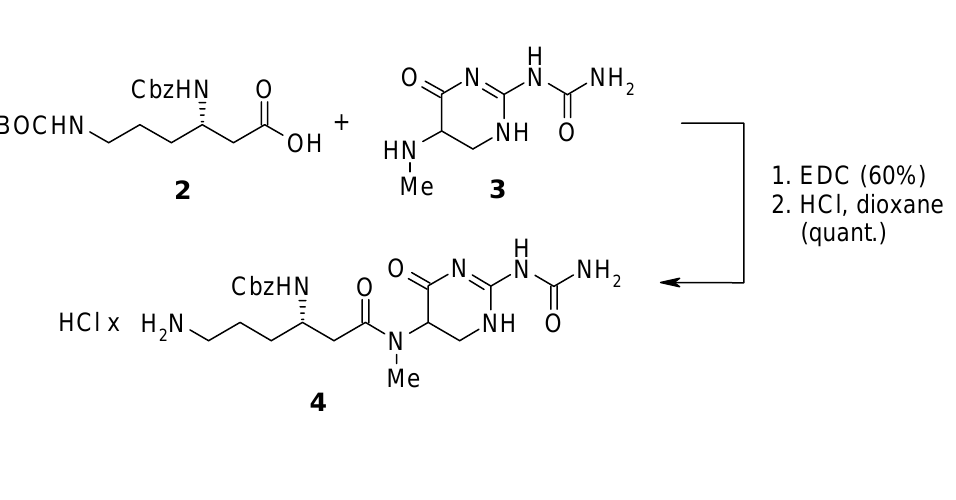
Scheme 1: Synthesis of amine 4